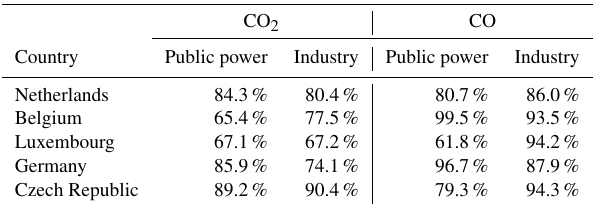
Table 3. Percentage (%) of emissions of CO 2 and CO (FF plus BF) that are attributed to large point sources (accounted for in databases) for public power and industry source sectors. CO 2 CO Country Public power Industry Public power Industry Netherlands 84.3% 80.4% 80.7% 86.0% Belgium 65.4% 77.5% 99.5% 93.5% Luxembourg 67.1% 67.2% 61.8% 94.2% Germany 85.9% 74.1% 96.7% 87.9% Czech Republic 89.2% 90.4% 79.3%